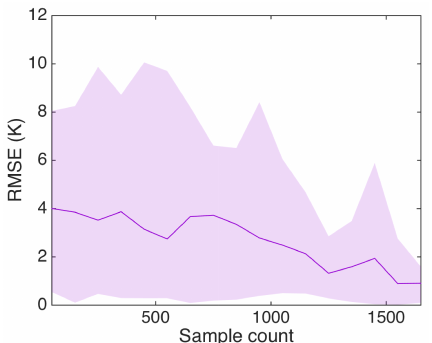
Figure A2. The relationship of RMSE of TB to OIB sample count ( M ). The statistics of RMSE of TB are computed for each sample count bin (each of 100). Shaded area covers the 5th and 95th per- centile of the absolute TB